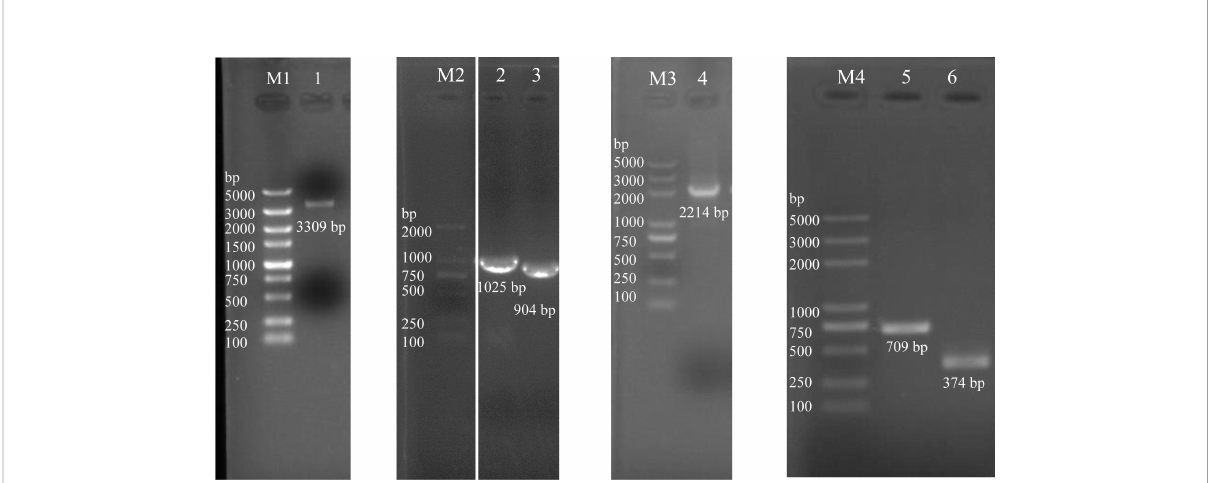
FIGURE 2 PCR identi fi cation of D lrp construction in V. alginolyticus . M1: 5,000 DNA marker (Guangzhou Dongsheng Biotech Co., Ltd.); M2: 2,000 DNA marker (Guangzhou Dongsheng Biotech Co., Ltd.); M3 and M4: 5,000 DNA marker (Tsingke Biotechnology Co., Ltd.); lane 1: pSW7848 linearized plasmid; lane 2: upstream fragment of lrp ; lane 3: downstream fragment of lrp ; lane 4: detecting of the recombination plasmid of pSW7848- lrp up- lrp down; lane 5: ampli fi cation fragment of wild strain with primers of Del- lrp -check-F/R; lane 6: ampli fi cation fragment of D lrp with primers of Del- lrp -check-F/R. This fi gure is the combination result of four gel pictures, and they are M1/1, M2/2/3, M3/4, and M4/5/6, respectively. In the gel M1/1, we cut all the lanes on the right of lane 1; in the gel M2/2/3, we cut a lane between lane M2 and lane 2, and cut all the lanes on the right of lane 3, then we spliced the lane M2 and lane 2/3, and there is a space between M2 and lane 2 showing the splicing; in the gel M3/4, we cut all the lanes on the right of lane 4; in the gel M4/5/6, we cut all the lanes on the right of lane